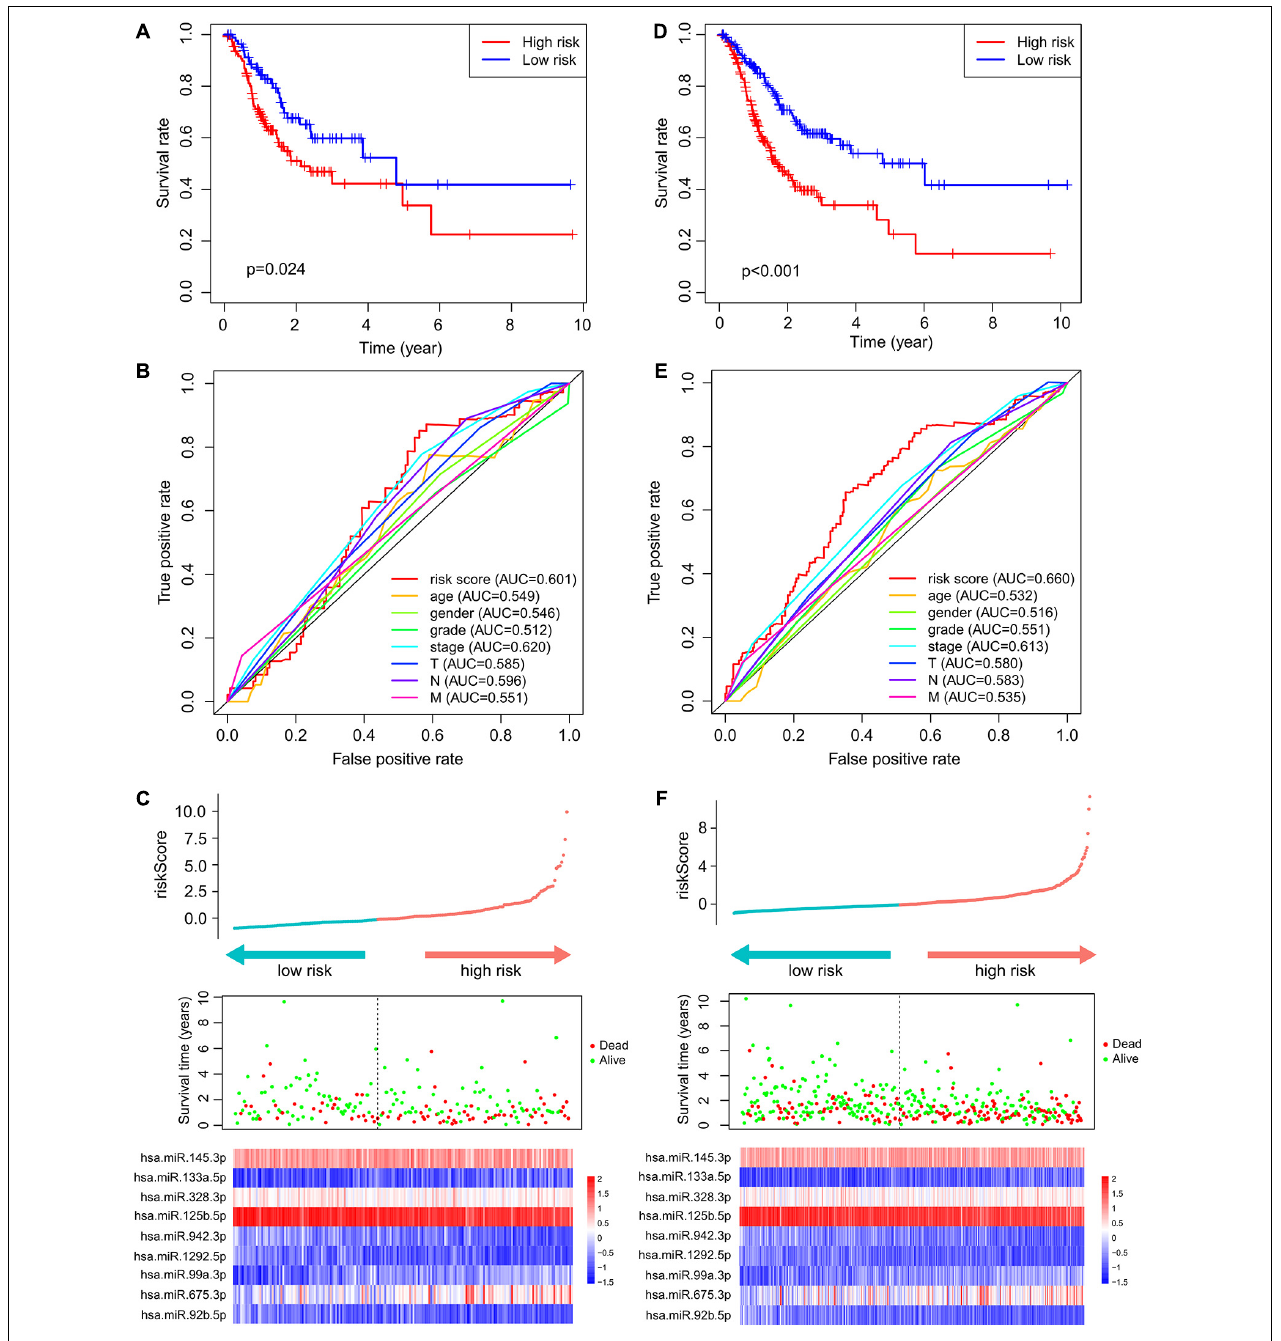
FIGURE 2 | Independent validation of the ImmiRSig in different cohorts. The Kaplan–Meier survival curve of patients in high- and low-risk groups in the testing (A) and entire TCGA cohorts (D) . ROC curve of ImmiRSig, age, gender, grade, stage, and T, N, M in the testing (B) and entire TCGA cohorts (E) . Risk score distribution, survival status, and microRNA expression patterns for patients in high- and low-risk groups by the ImmiRSig in the testing (C) and entire TCGA cohort (F) .